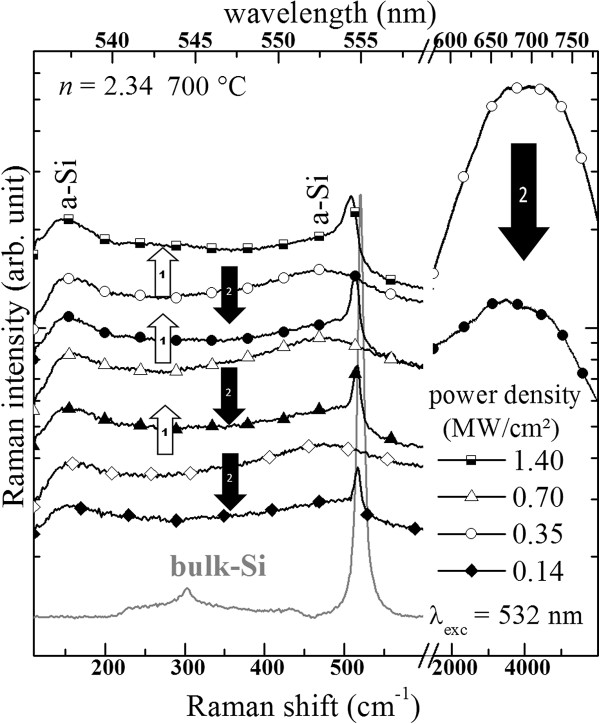
Laser annealing effect on the Raman spectra of SiNxfilms deposited on fused silica substrates.